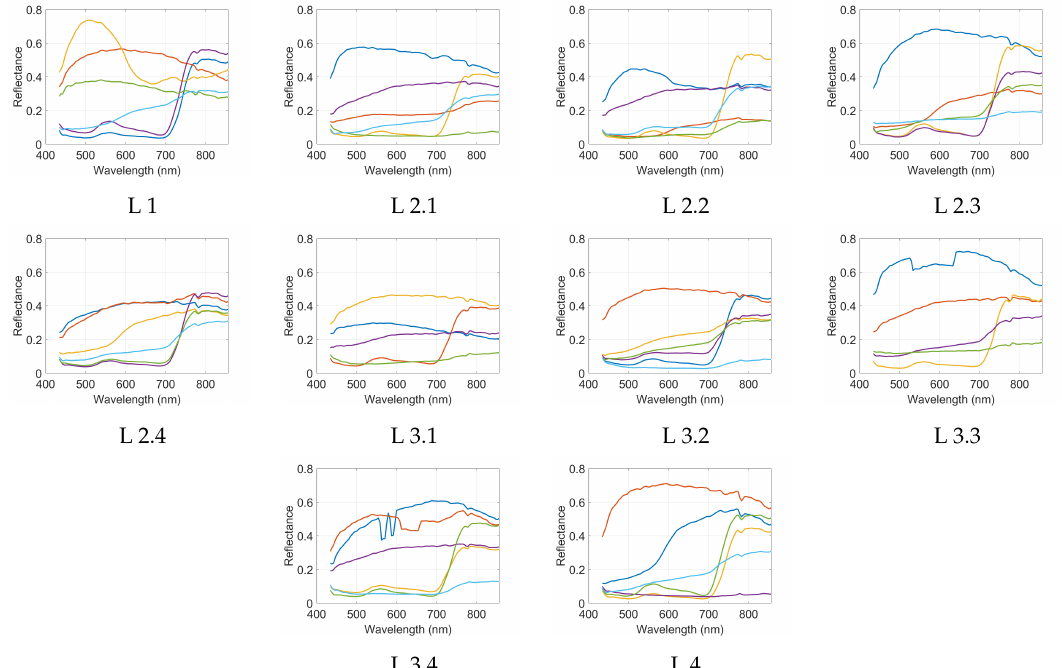
Figure 21. Spectral endmembers for each leaf tile for the Pavia image.